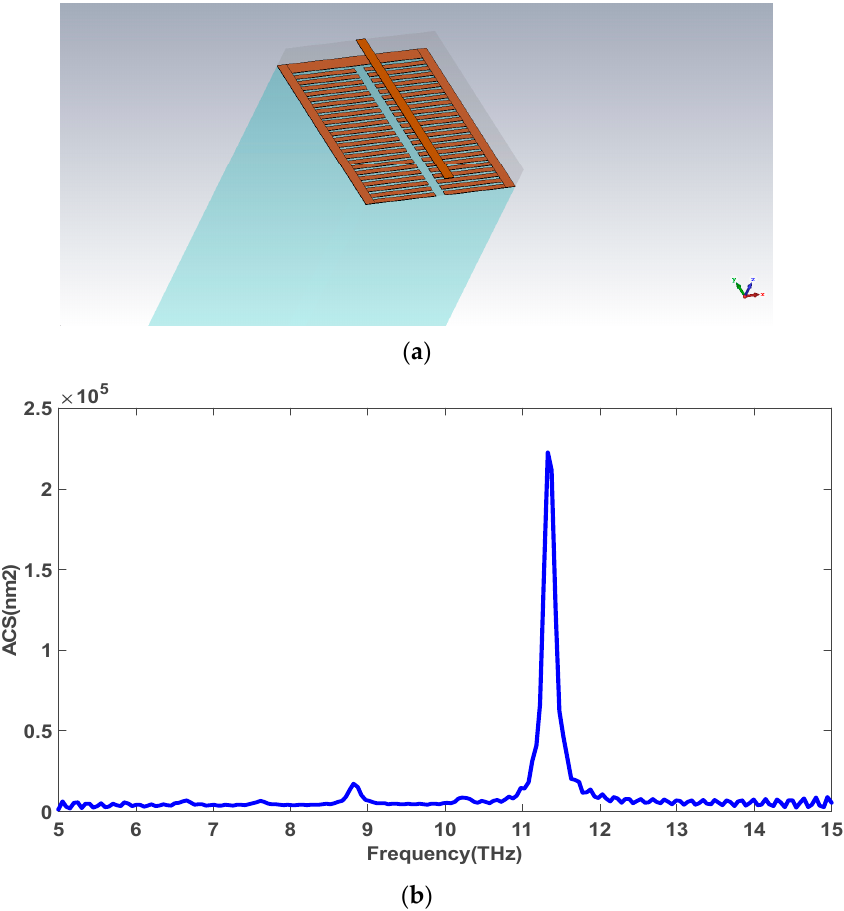
Figure 2. ( a ) the implemented configuration of THz combline perfect absorber, ( b ) Absorption Cross Section (ACS) of the proposed